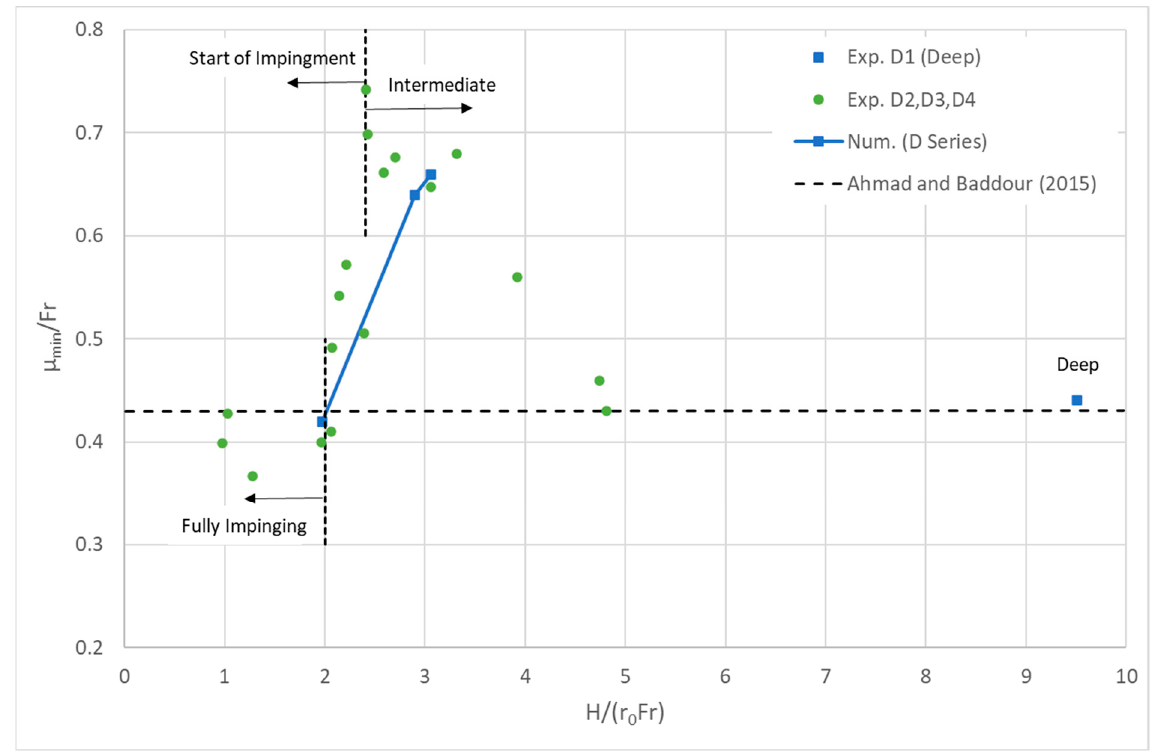
Figure 7. Minimum dilution at the return point of vertical dense discharges in shallow waters [3].